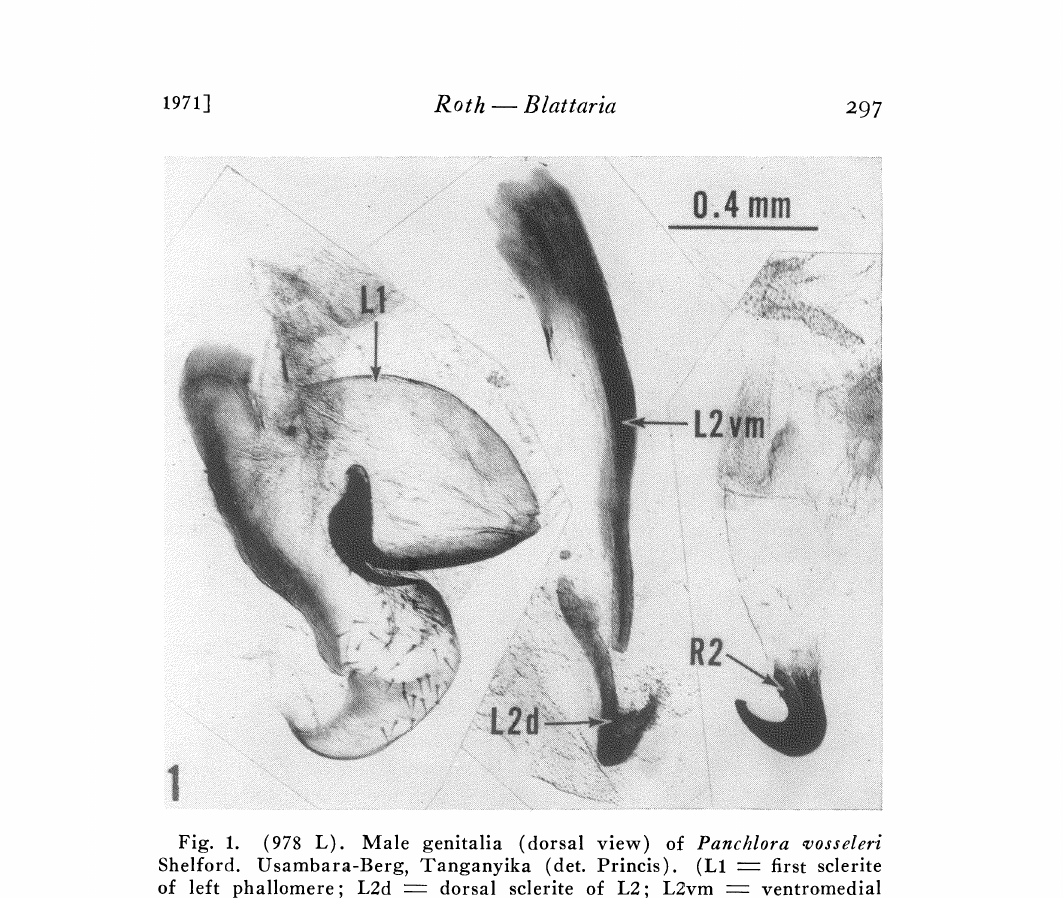
Fig. 1. (978 L). Male genitalia (dorsal view) of Panchlora eosseleri Shelford. Usambara-Berg, Tanganyika (det. Prineis). (L1 first selerite of left phallomere; L2d dorsal selerite of L2; L2vm ventromedial selerite; R2 hooked selerite of right phallomere. To conserve space the photographs of the phallomeres have been placed closer together than they were arranged on the